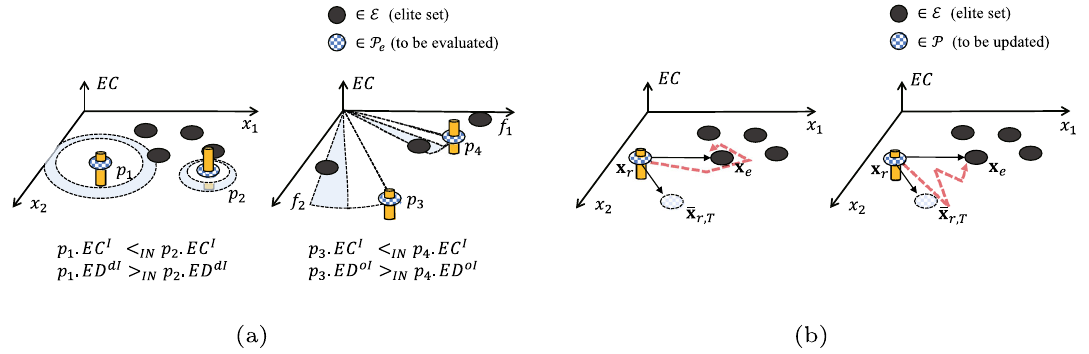
Fig. 2 Diagrams of a performance intervals in decision space and objective space for individual comparison; b evolving trends corresponding to different ϕ values: (left) small ϕ ; (right) large